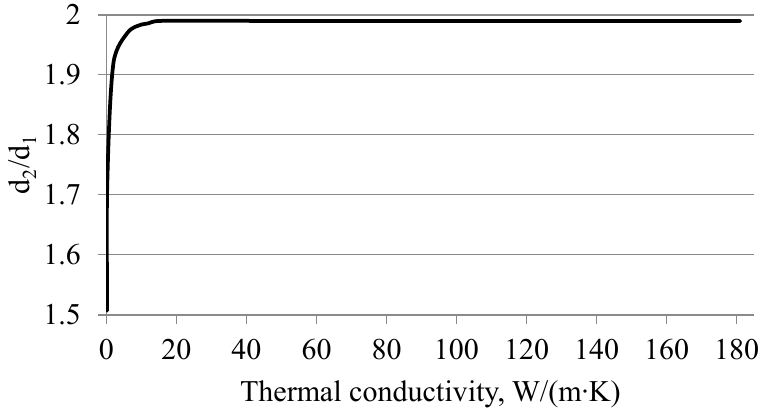
Figure 2. Dependence of d 2 / d 1 (ratio of the outer diameter of the flowmeter tube to the diameter of the heater) on the thermal conductivity of various materials, subject to the slightest influence on the radial heat flow.